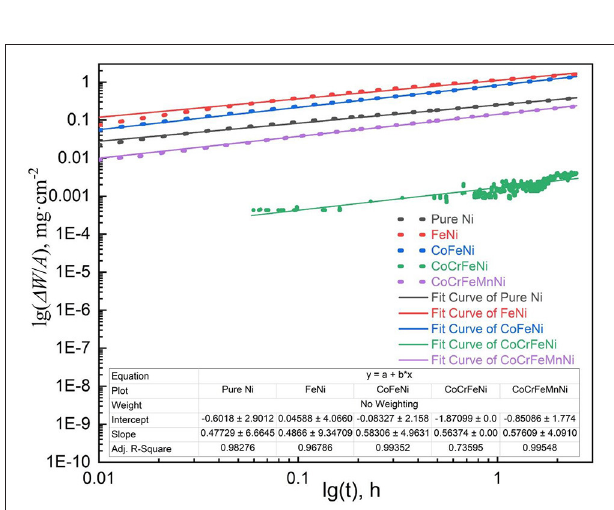
FIGURE 3 | The logarithm of the weight gain per unit surface area, 1 W / A , vs. logarithm of time.